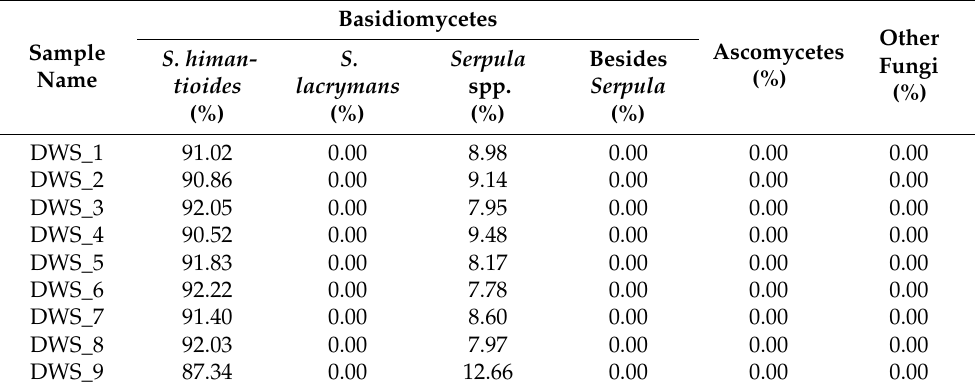
Table 2. Percentage of reads of fungi detected by amplicon sequencing using the species-specific primer set for Serpula himantioides